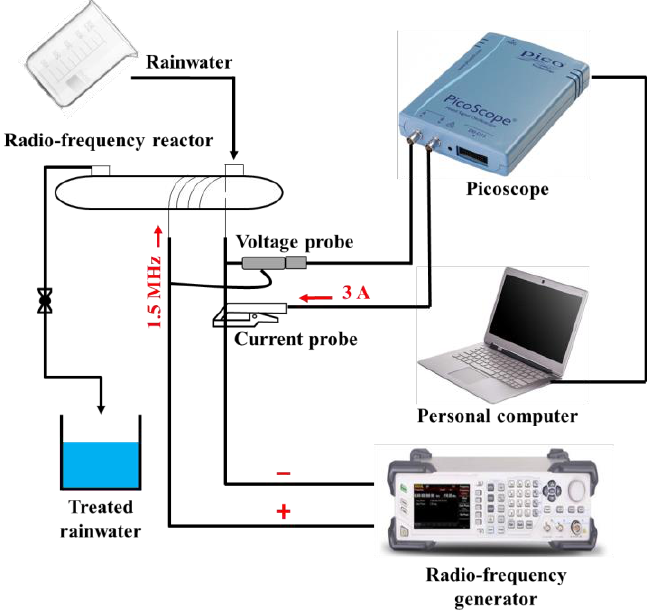
Figure 1. Experimental set-up of an RF treatment.